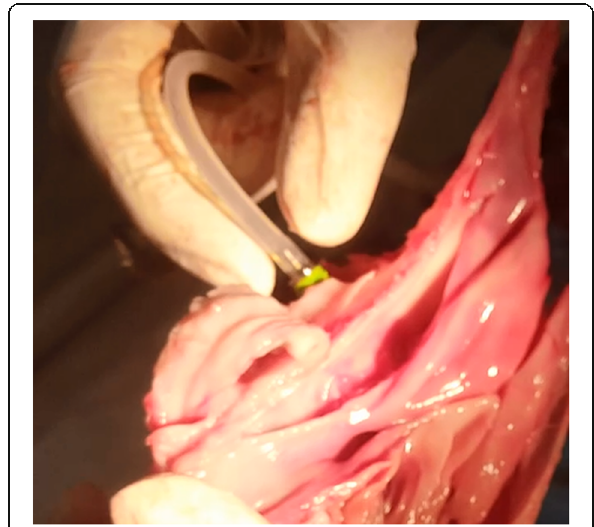
Fig. 6 The hydraulic lifter stabilized in the osteotomy before injecting the saline